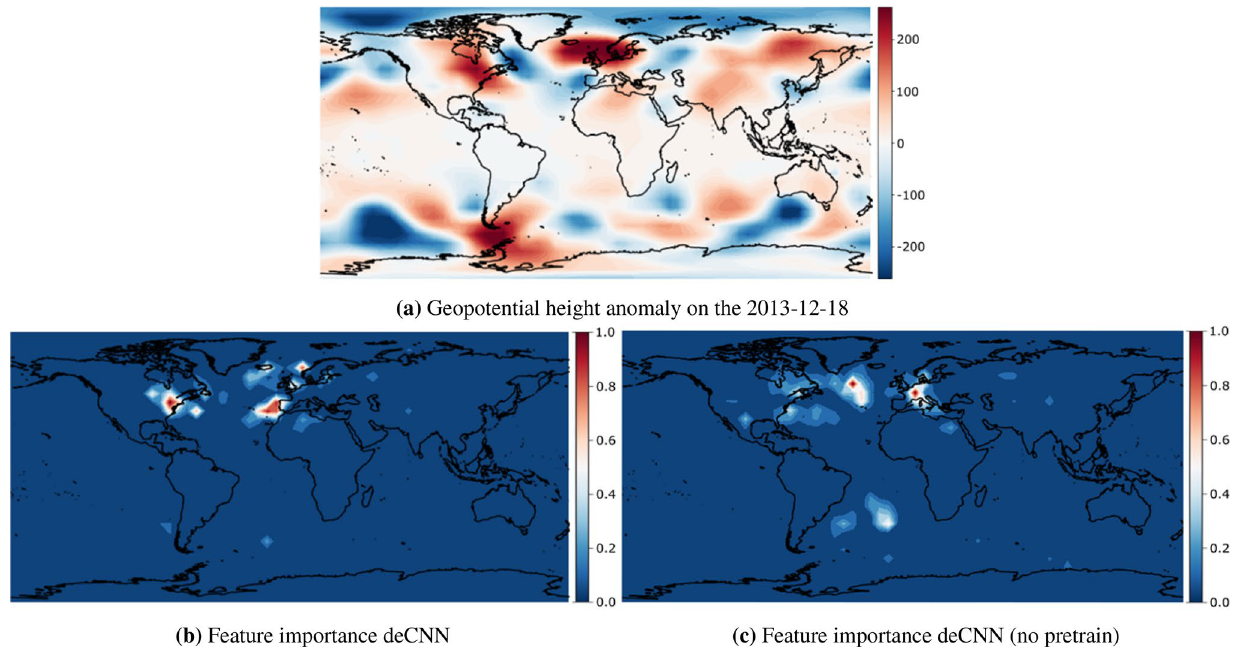
Figure 3. SB transition to NAO- occurring from the 2018-11-13 to the 2018-11-24. The top ( a ) denotes the geopotential height anomaly input used by our model to make a regime prediction 11 days prior. The lower left ( b ) denotes the relevant regions for making that prediction for the deCNN model, and lower right ( c ) denotes the relevant regions for the deCNN model without transfer learning. Feature importances are normalized to lie between 0 and 1. Figures are created using cartopy 0.19.0 and matlotlib